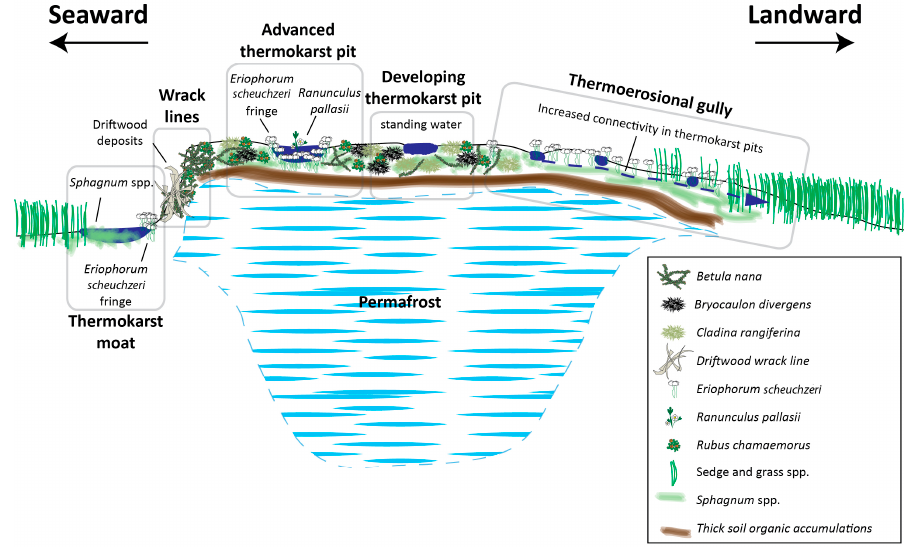
Figure 3. Conceptual model of permafrost plateau morphology, vegetation, permafrost thickness, and thermokarst processes. The Lowland Moist Graminoid Shrub meadow (LMGSM) ecotype is associated with the permafrost plateaus, which are surrounded by other, wetter coastal meadow ecotypes. There is typically an abrupt transition from coastal meadow to plateau on the seaward margin, and a gradual transition between ecotypes on the landward margin. Thick organic accumulations on the permafrost plateaus help to insulate underlying permafrost during summer. Indicators of various stages of permafrost degradation are highlighted with grey boxes.